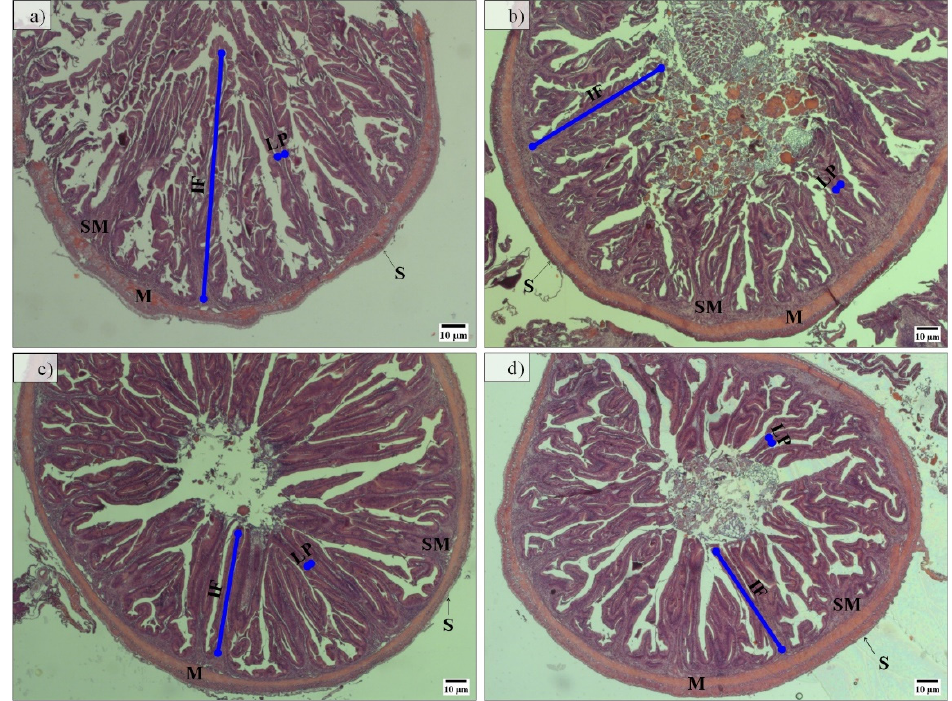
Figure 3. Representative hematoxylin and eosin-stained histological sections of midgut from fish fed FM-P50/CH10 ( a ), FM-P40/CH20 ( b ), PF-P50/CH10 ( c ), and PF-P40/CH20 ( d ). IF, intestine fold; LP, lamina propria; M, muscularis layer; S, serosa layer; SM, submucosa layer. Intestine fold height showed higher histomorphology deformations in fish fed the PF-based diets ( c , d ) than in fish fed the FM-based diets ( b ), except for fish fed the FM-P50/CH10 diet ( a ), which was not significantly different from fish fed the PF-P40/CH20 ( d ).